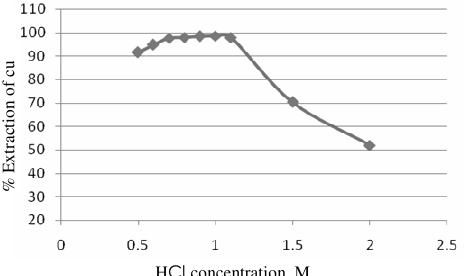
Figure 5. Effect of HCl concentration to extraction percentage of Cu(II).